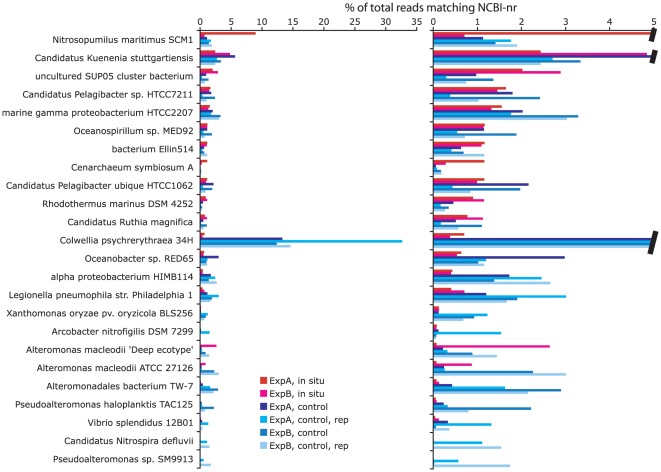
Top 10 most abundant taxa per dataset (in situ vs. control), as identified by the NCBI taxonomic affiliation of protein-coding genes matching sequence reads (as top BLASTX hit in searches against the nr database).The right panel shows the data at higher resolution (note change in axis units). Abundances are expressed as percentages of the total number of reads with matches in nr (per dataset). Data are ordered according to increasing rank abundance in the in situ dataset for Experiment A.